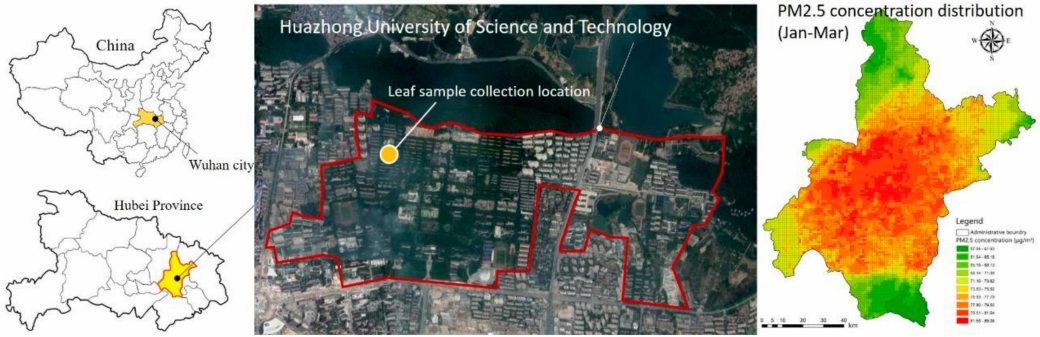
Figure1. Studyarea, leafsamplecollectionlocation, andthefineparticulatematter(PM 2.5 )concentration distribution (January to